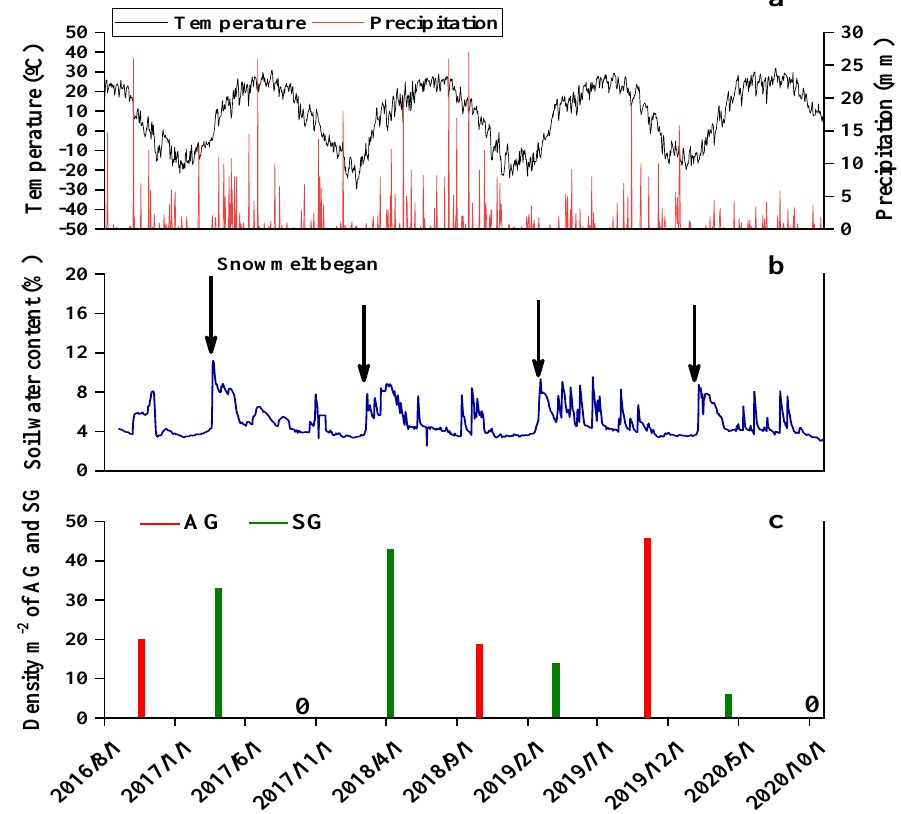
Figure 4. Soil temperature, precipitation ( a ), soil water content as a percentage of field weight at 5- cm-soil depth ( b ) and density of spring (SG)- and autumn (AG)-germinating plants of Erodium